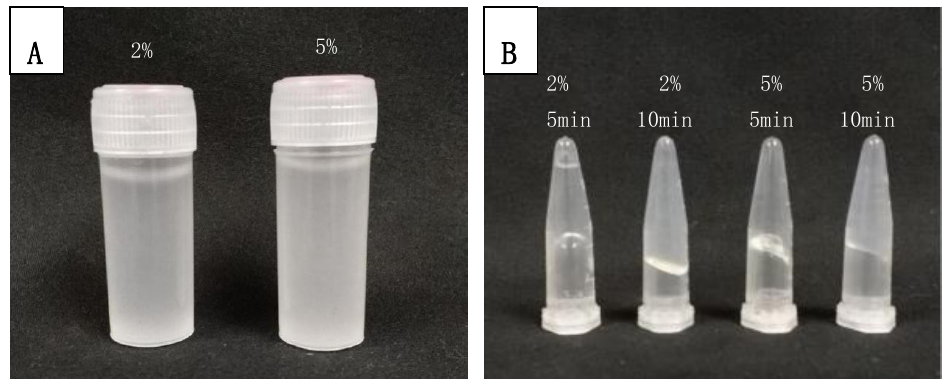
Figure 4. Preparation of cellulose solution ( A : 2 and 5 wt% NaOH treated samples) and nanocellulose sol ( B : 2 wt% NaOH and 5 min sonication; 2 wt% NaOH and 10 min sonication; 5 wt% NaOH and 5 min sonication; 5 wt% NaOH and 10 min sonication) from PCF. Forests 2019 , 10 , 749